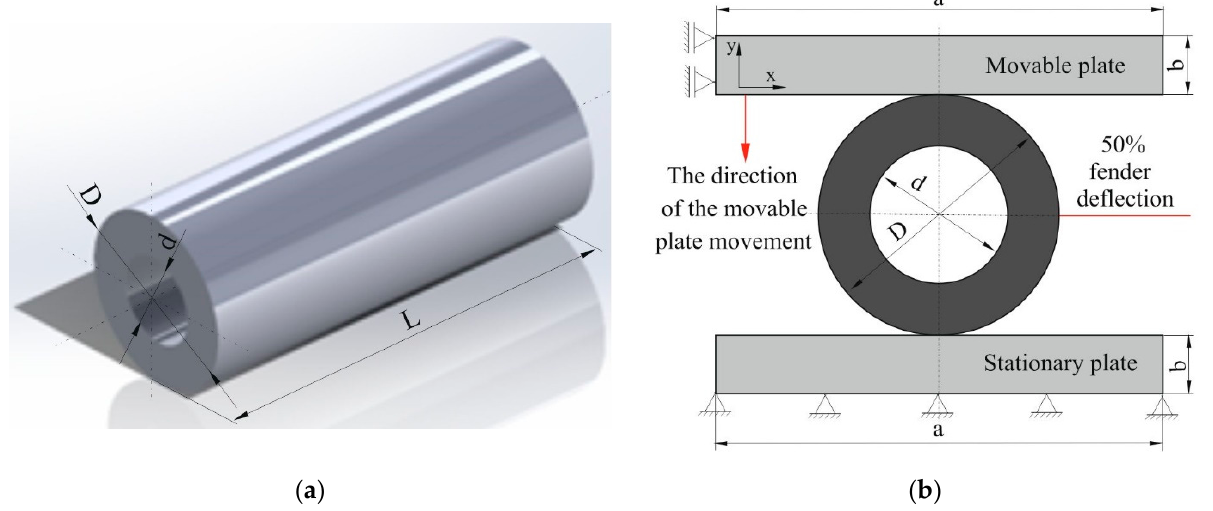
Figure 2. Model of a cylindrical fender. ( a ) Basic model of a cylindrical fender; ( b ) Basic computational model of a cylindrical fender taking into account the use conditions.